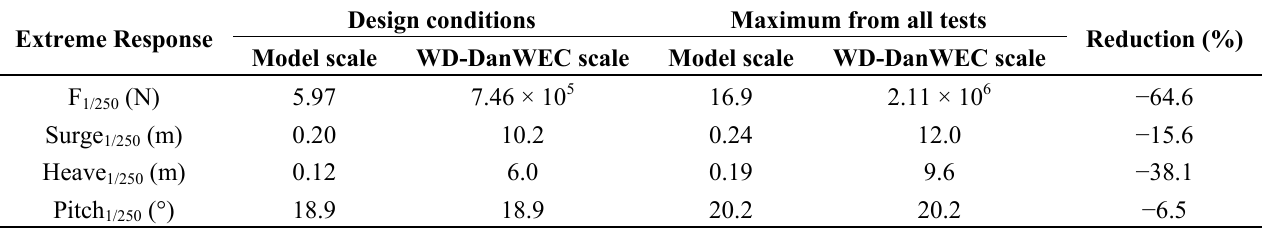
Table 6. Mooring tension and motion response in design conditions and maximum experienced. Reductions achievable (%) by adopting design conditions are also